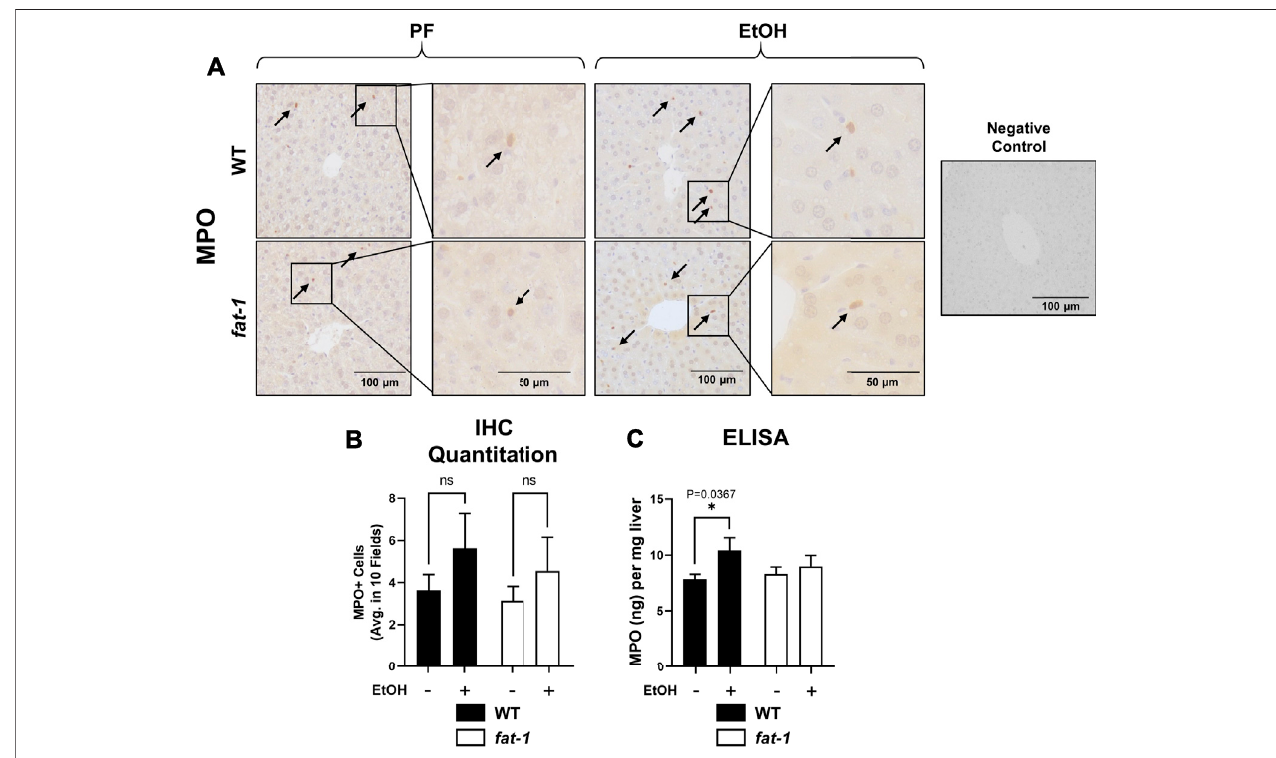
FIGURE 3 | Hepatic neutrophil in fi ltration. (A) Immunohistochemistry staining for MPO expression. Arrows indicate MPO+ cells. Images are 200X, insets are 400X magni fi cation. (B) Quantitation of number of MPO+ cells in representative digital microscope fi elds. (C) MPO levels as determined by ELISA, p < 0.05, one-way ANOVA (comparisons not signi fi cant if unlabeled). WT PF ( n (cid:1) 14), fat-1 PF ( n (cid:1) 9), WT EtOH ( n (cid:1) 8), fat-1 EtOH ( n (cid:1)